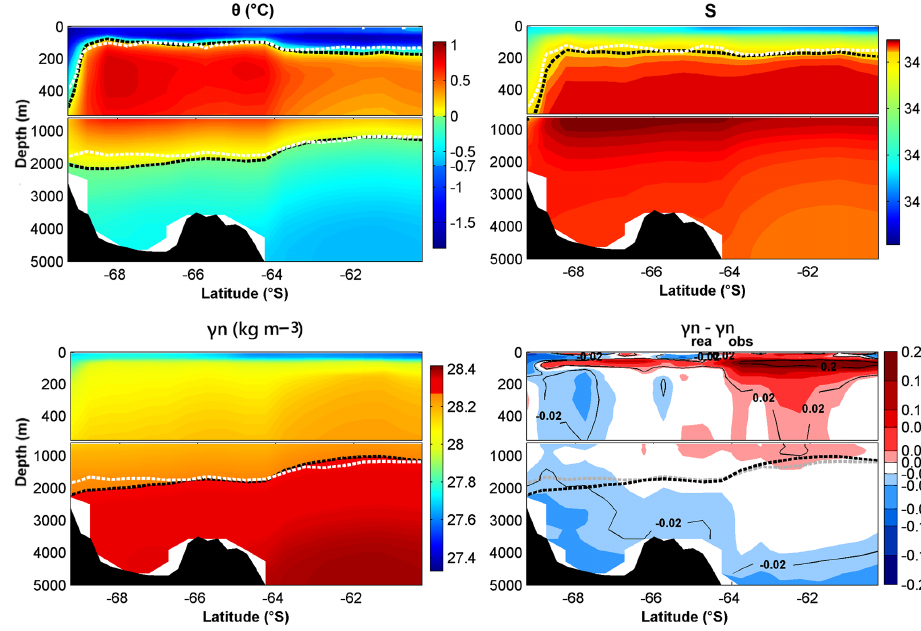
Figure 11. Same as in Fig. 9, except for section WOCE